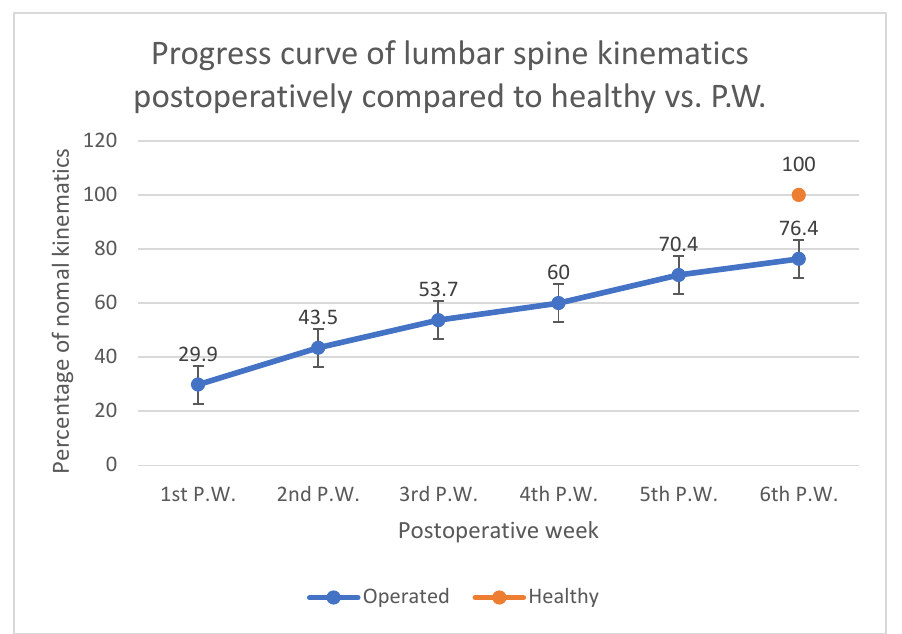
Figure 12. Percentage evolution of lumbar spine kinematics postoperatively compared to healthy, in relation to postoperative week.